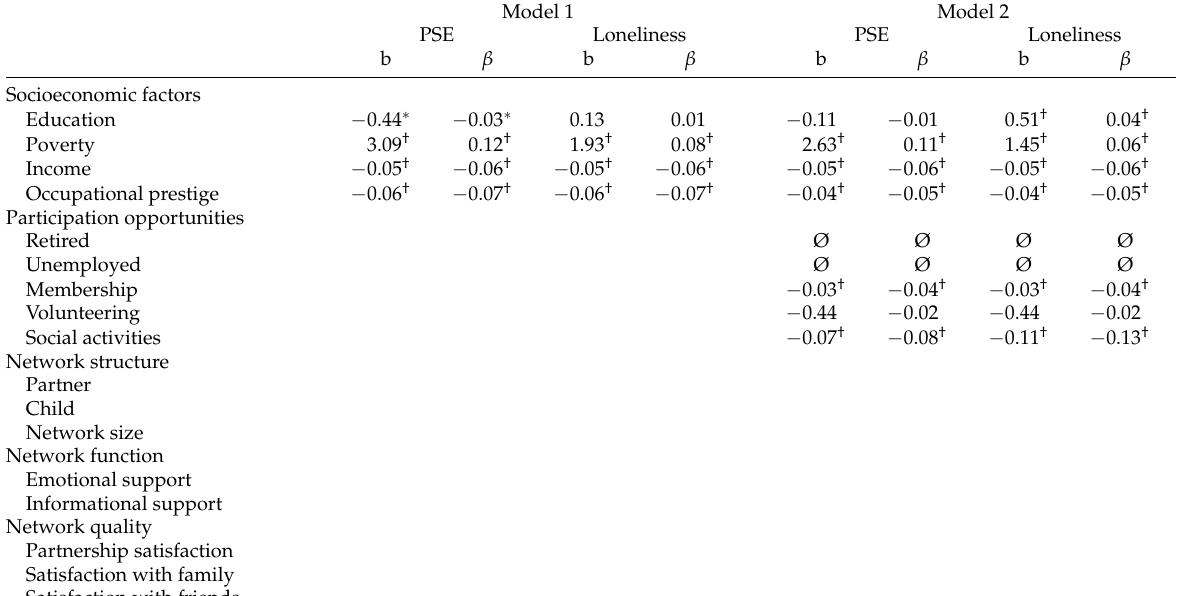
Table 1: Regression weights linking risk factors to PSE and loneliness in five successive